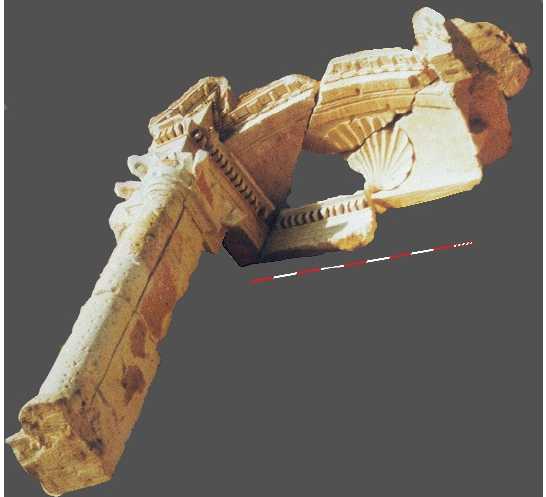
Figure 17. Remains of an aedicula from house H9 pieced together by Wiktor A. Daszewski (photo Courtesy of Wiktor A. Daszewski; after Czerner 2009, Figure 64).